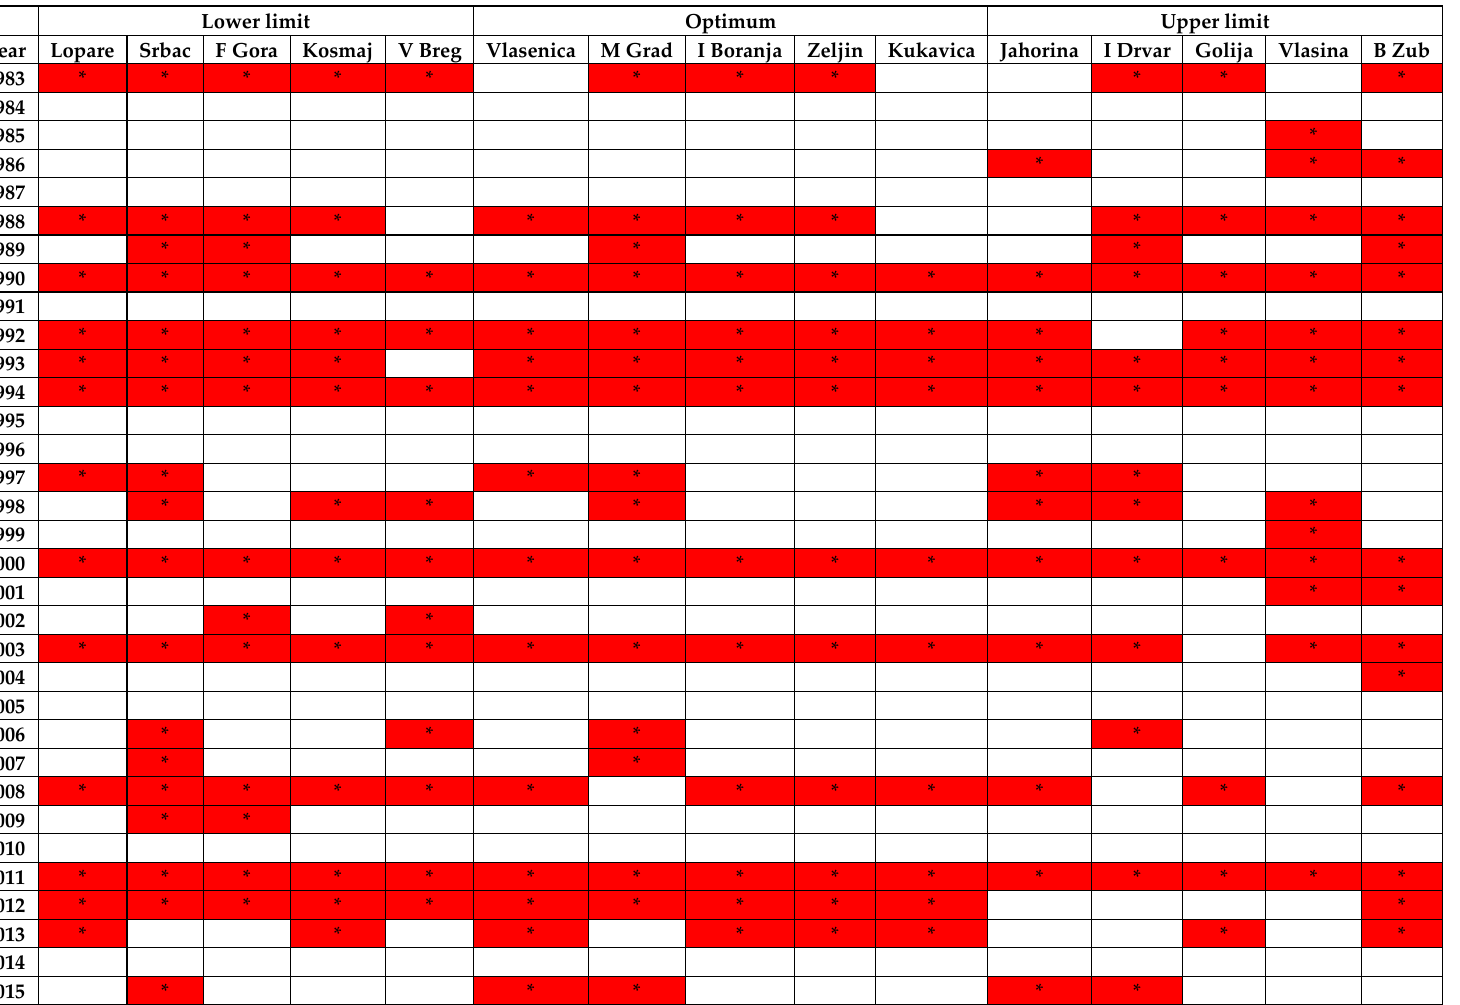
Table A2. Cont . Atmosphere 2018 , 9 , x FOR PEER